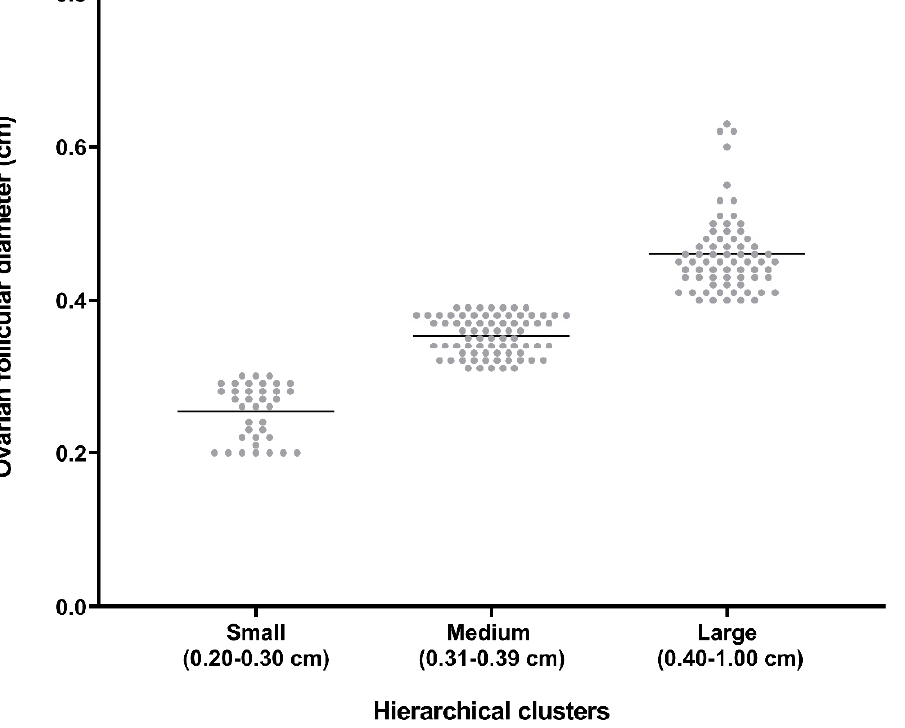
Table 1. Distribution of sows (number and proportion in brackets) showing small (0.20–0.30 cm),